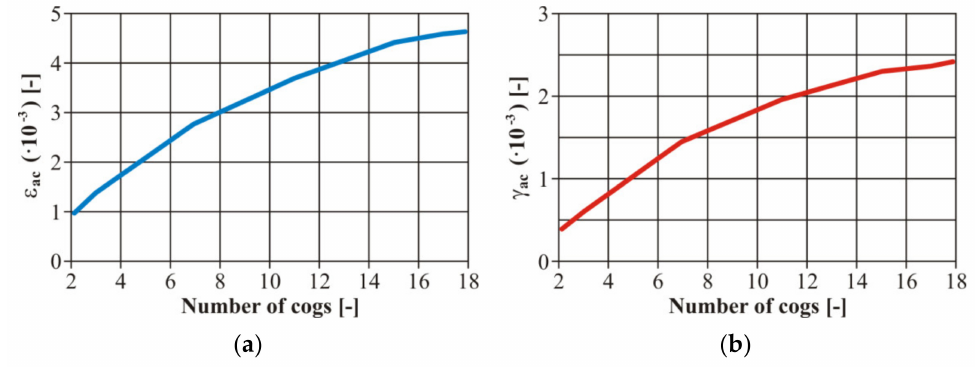
Figure 15. The final calibration curves of the total deformation of the basic material EN AW 6063: ( a ) the stress by bending; ( b ) the stress by torsion.